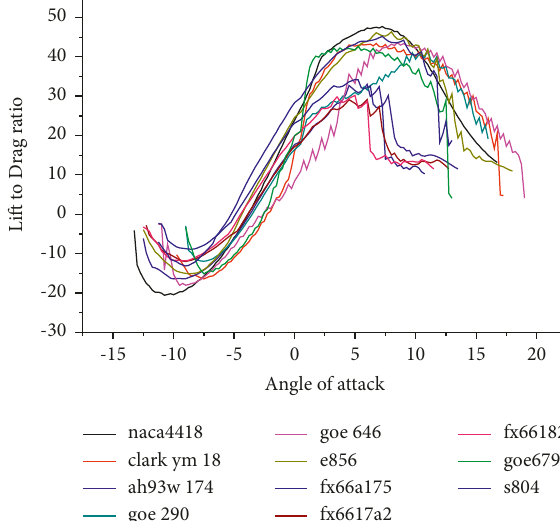
Figure 1: Lift-to-drag ratio against the angle of attack for different airfoils.